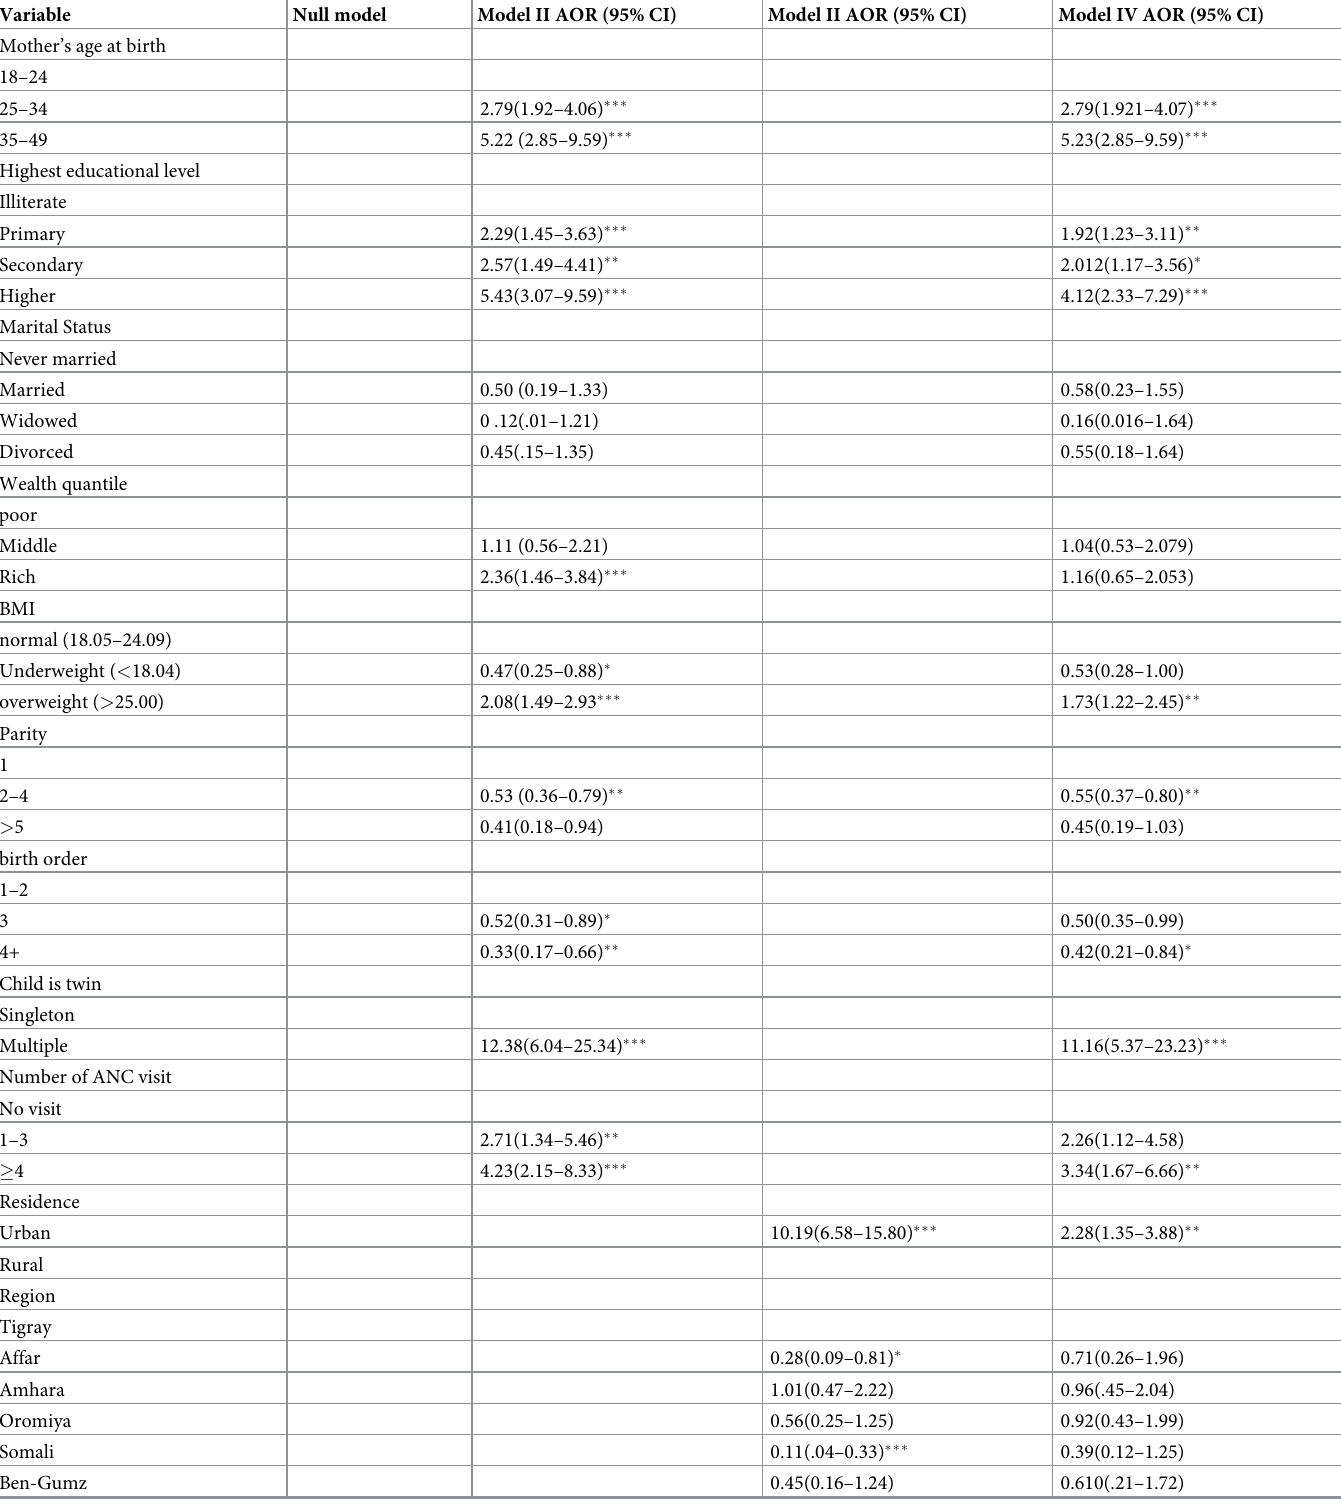
Table 4. Multilevel multivariable logistic regression output for cesarean section rate among live births in Ethiopia